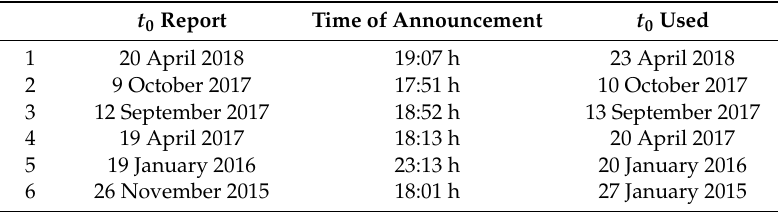
Table A3. CSR-relevant messages between 17:31h and 23:59h.